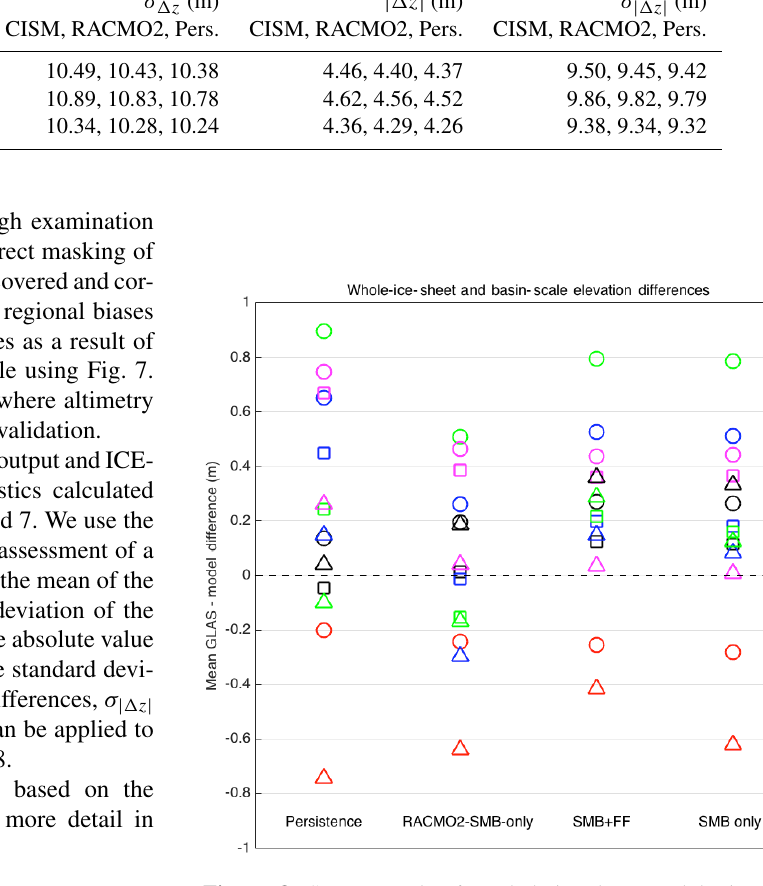
Table 2. Whole-ice-sheet metrics for model vs. ICESat observations (ICESat-model) for the SMB + FF simulation. For reference, results for the idealized simulations, “RACMO2-SMB-only” (RACMO2) and “persistence” (Pers.) are also shown. Date (yr) (cid:49)z (m) σ (cid:49)z (m) | (cid:49)z | (m) σ | (cid:49)z | (m) CISM, RACMO2, Pers. CISM, RACMO2, Pers. CISM, RACMO2, Pers. CISM, RACMO2, Pers.